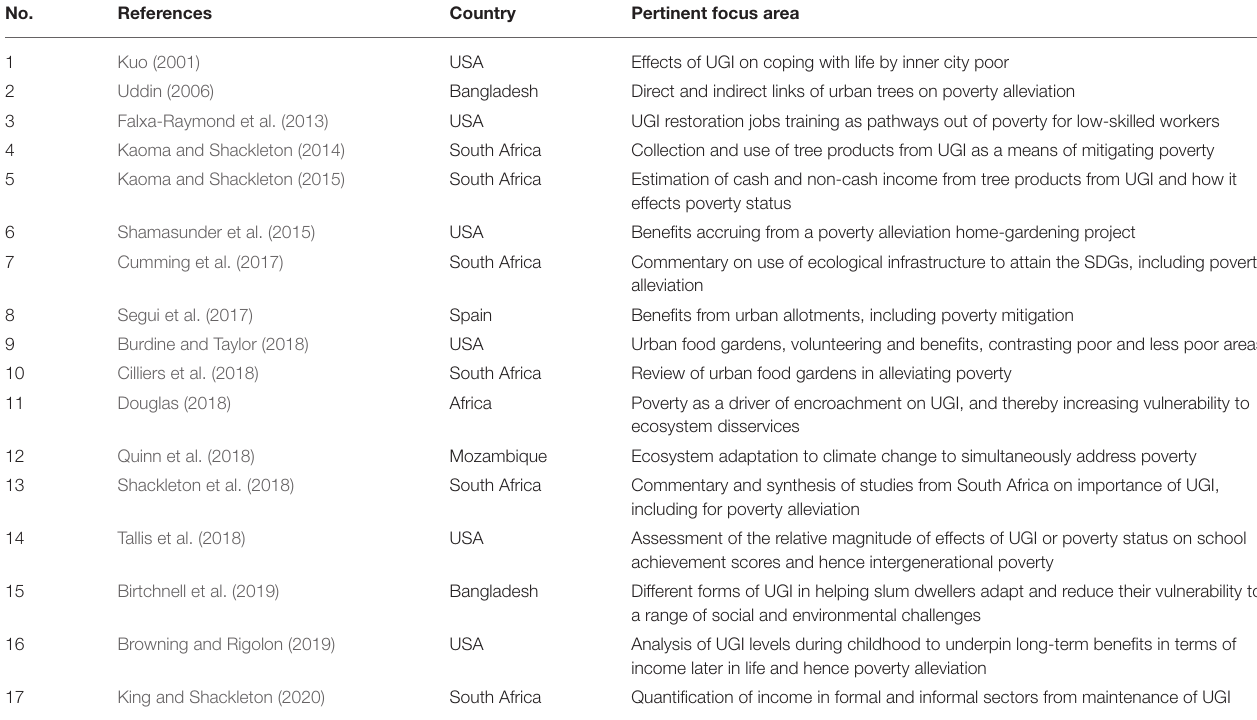
TABLE 1 | Seventeen studies considering one or more links between urban greening/infrastructure and poverty alleviation, arranged in chronological order (see section on “Research lacuna” for method).